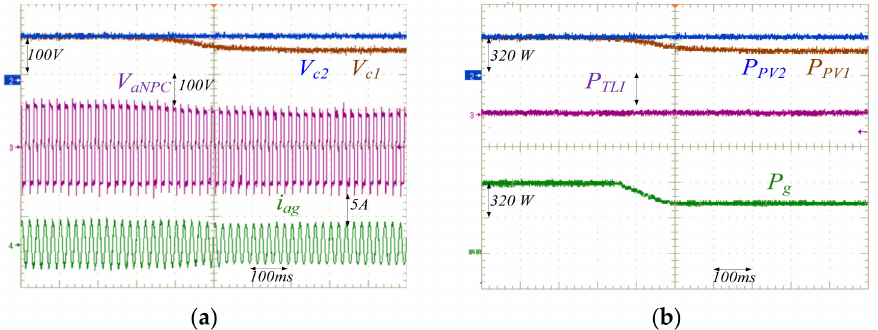
Figure 15. The (3LI + TLI) photovoltaic (PV) power variation. ( a ) PV voltages V c 1 and V c 2 , NPC output voltage V NPCj , and grid current i gj . ( b ) PV power P PV 1 and P PV 2 , TLI output active power P TLI , and grid active power P g . ( V g = 150 V, 50 Hz V DC (cid:48)(cid:48) = 100 V, TLI 10 kHz PWM).